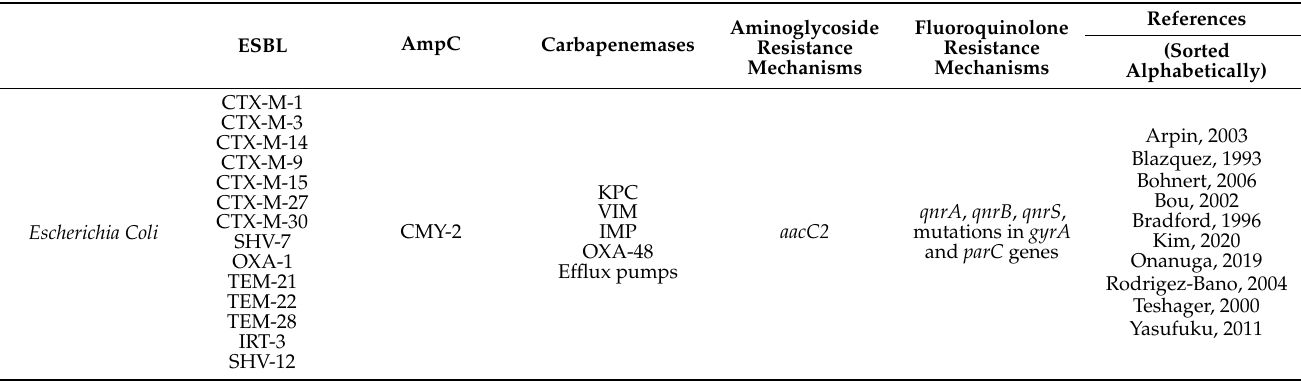
Table 1. A literature-informed summary of resistance mechanisms described in Gram-negative urinary